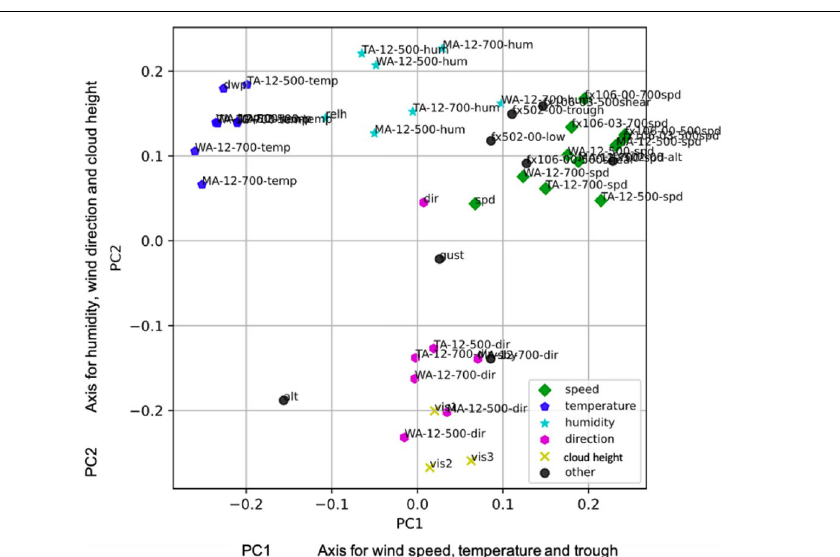
planes. As can be observed, the wind speed, contour lines, and trough elements are concentrated in the upper-right quadrant of the PC1-axis; the temperature elements, in the upper-left. It can be inferred that the farther the PC1 lies on the right-hand side, the higher the wind speed and the lower the temperature (i.e., there are many contour lines). Further, the humidity elements are present at the top of the plot, while wind direction and cloud height elements at the bottom indicating that in case of high humidity, the wind direction is negative. Thus, when most of the wind is from the west, on occurrence of turbulence, the wind from the southwest exerts a significant